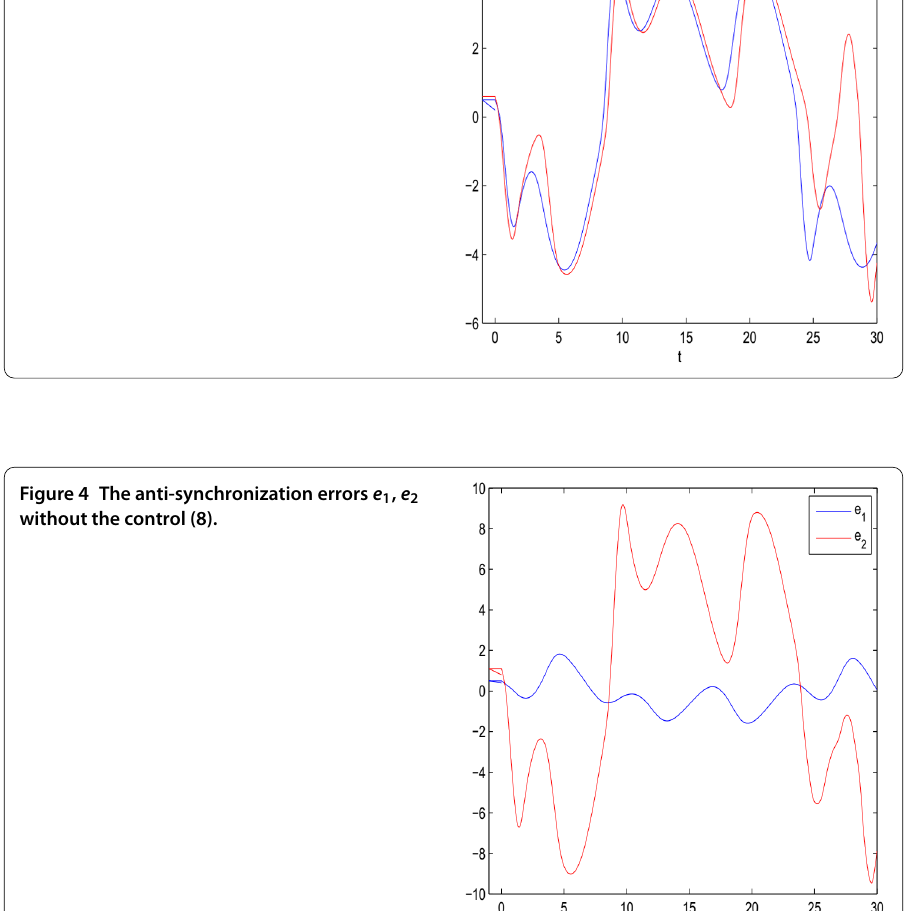
Figure 3 The state trajectories of x 2 , y 2 without the controller (8).